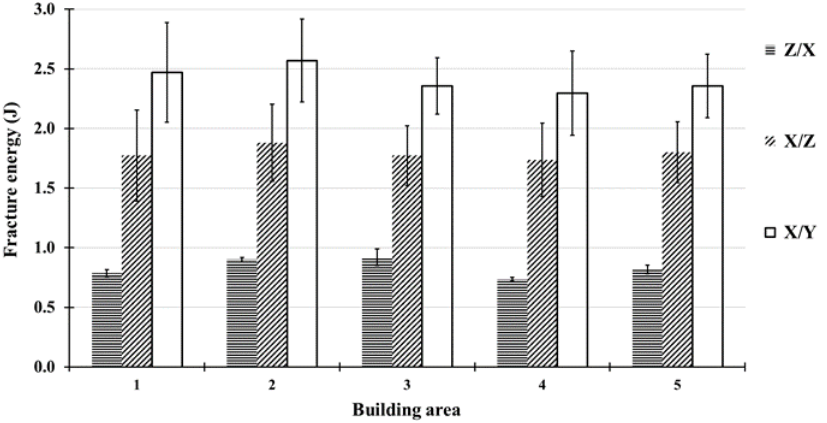
Figure 6. Fracture energy as a function of building and notch orientations according to the different production areas.